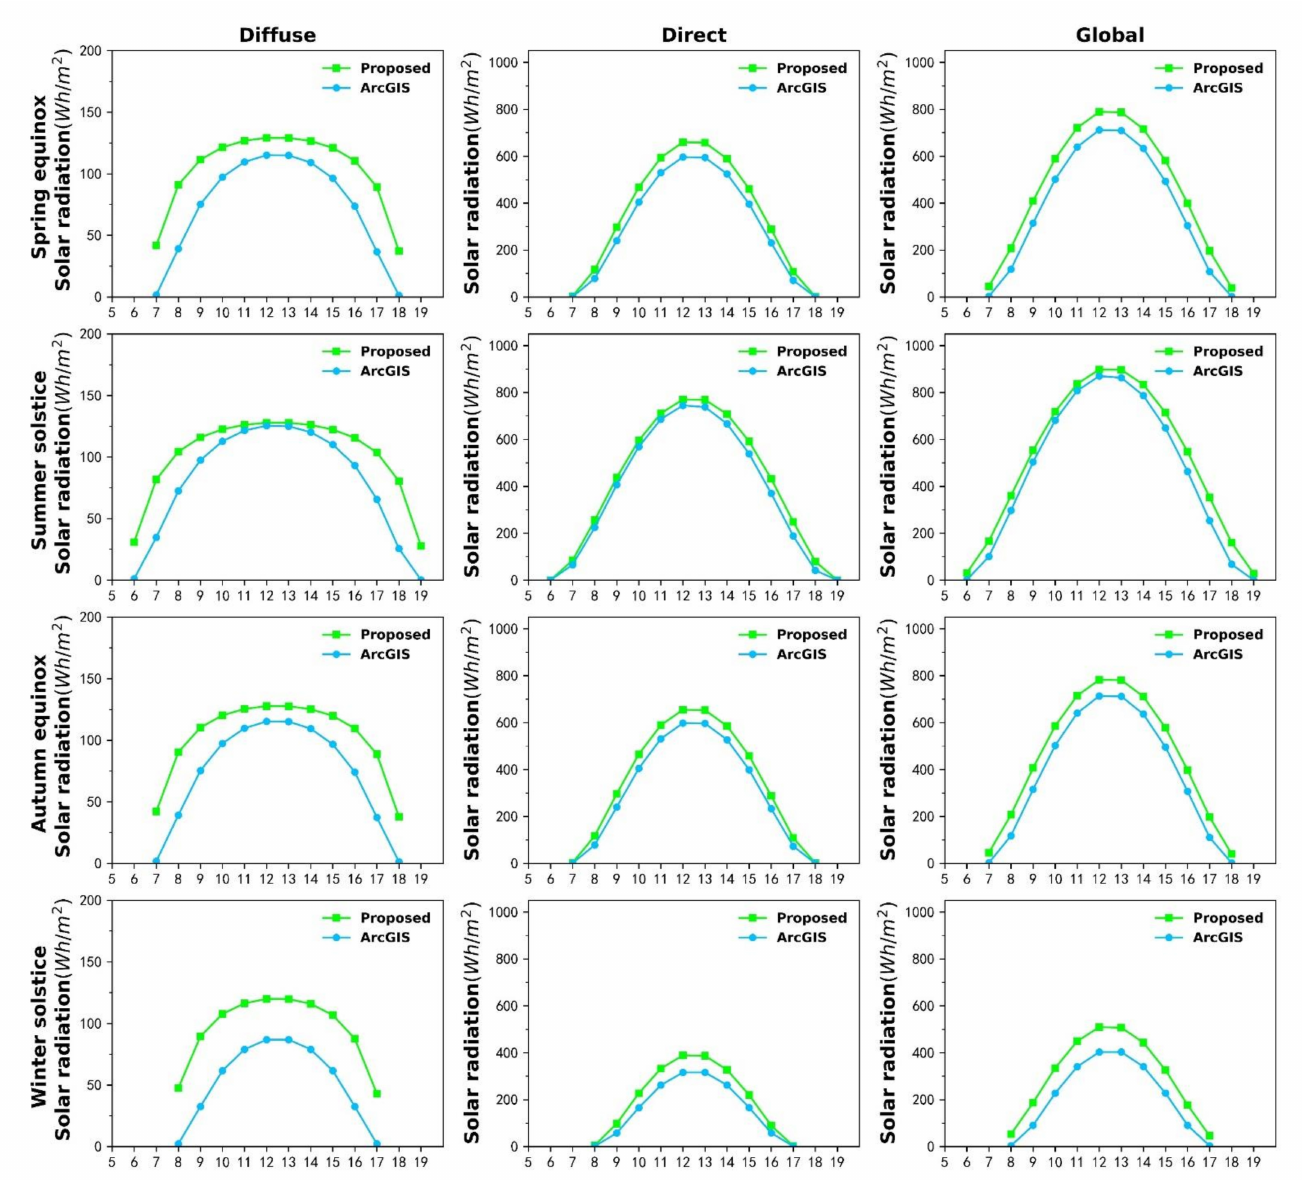
Figure 14. Comparison of diffuse radiation, direct radiation, and global radiation on four specific